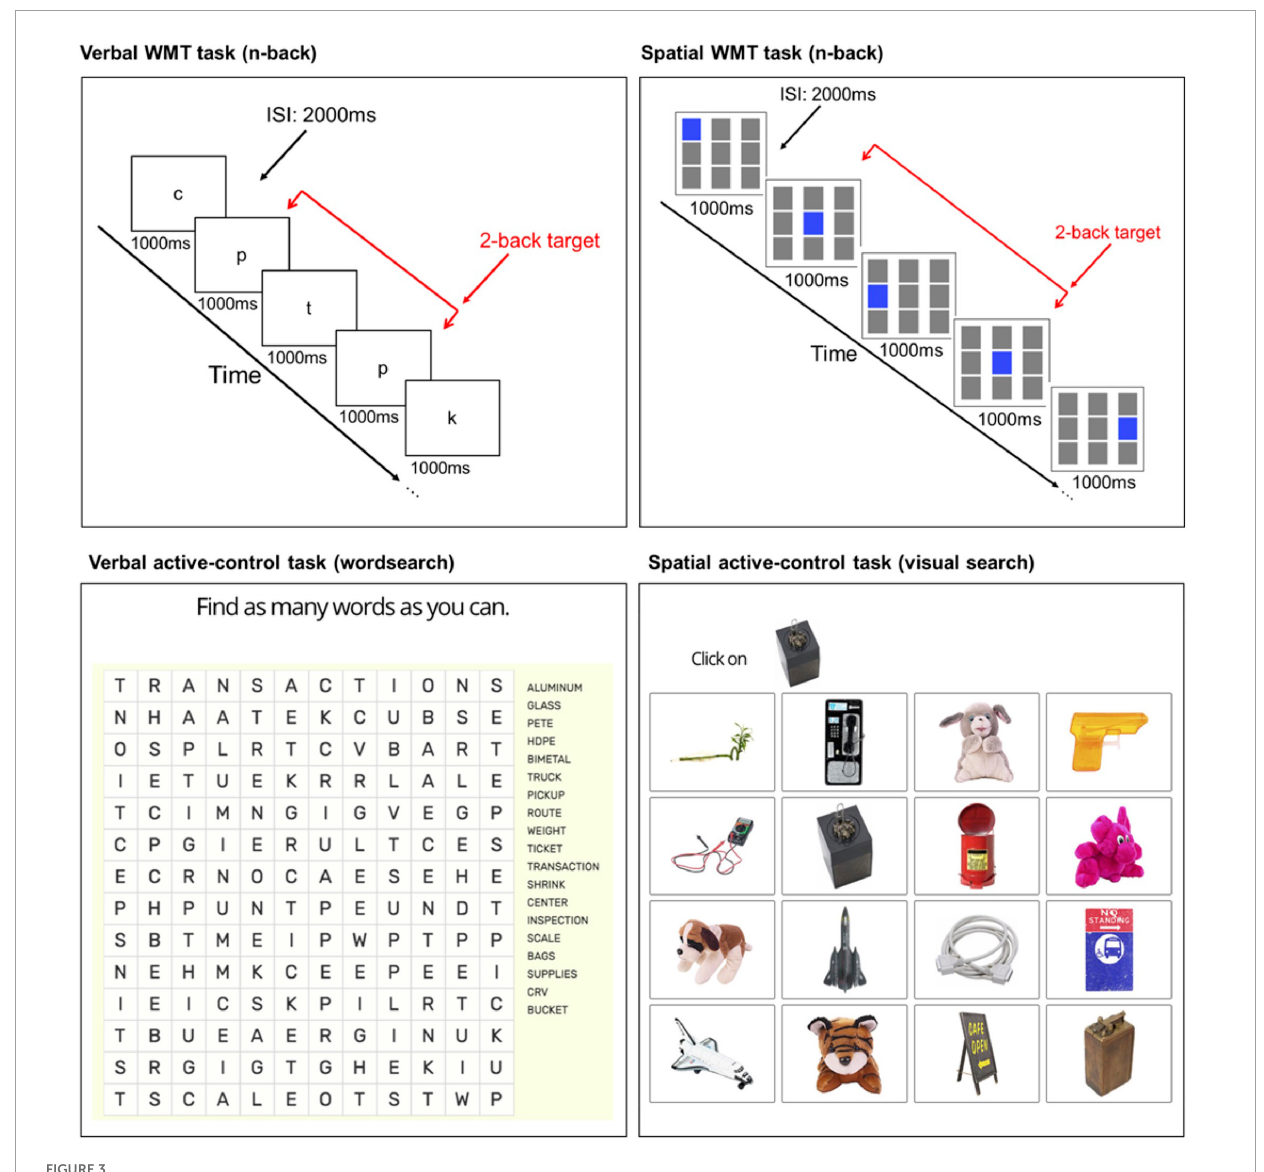
FIGURE3 Illustration of the WMT and active-control tasks. Verbal (top left) and spatial (top right) n-back WMT tasks at load level two (2-back). Example verbal (bottom left) and spatial (bottom right) active-control tasks. ISI, inter-stimulus